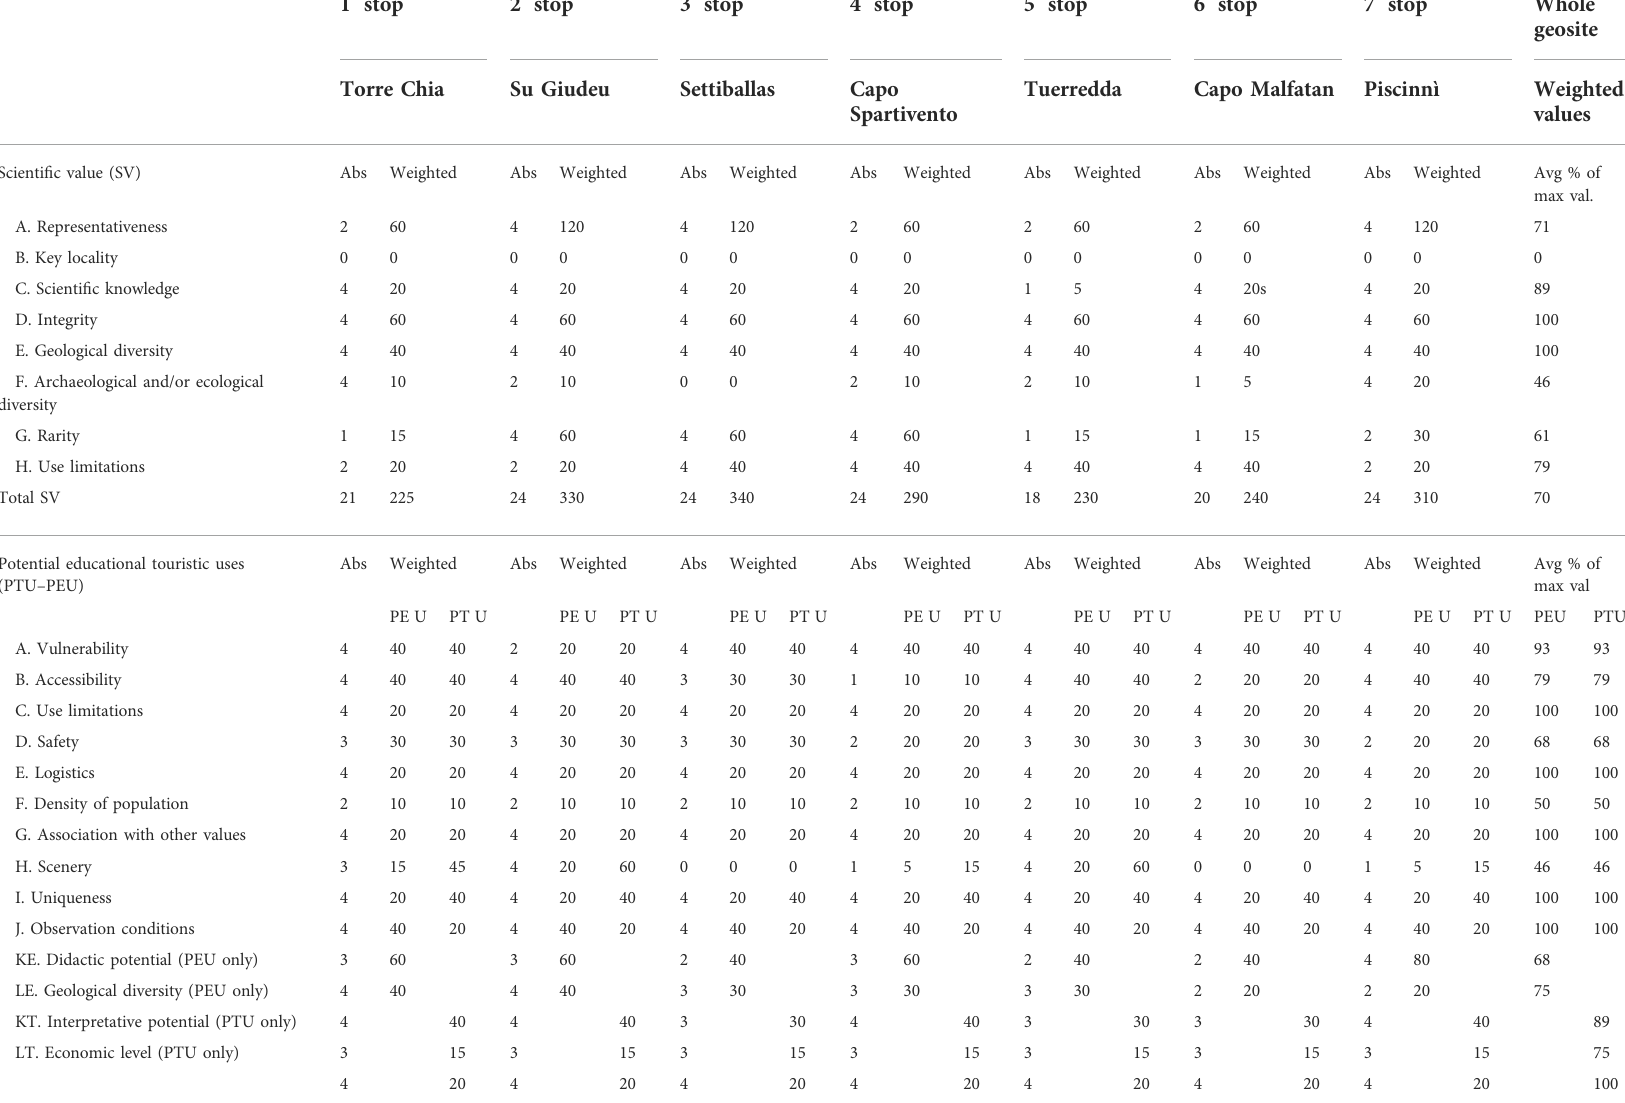
TABLE 3 Results of the quantitative assessment of the geosite ’ s value performed following a modi fi ed version of the method proposed by Brilha